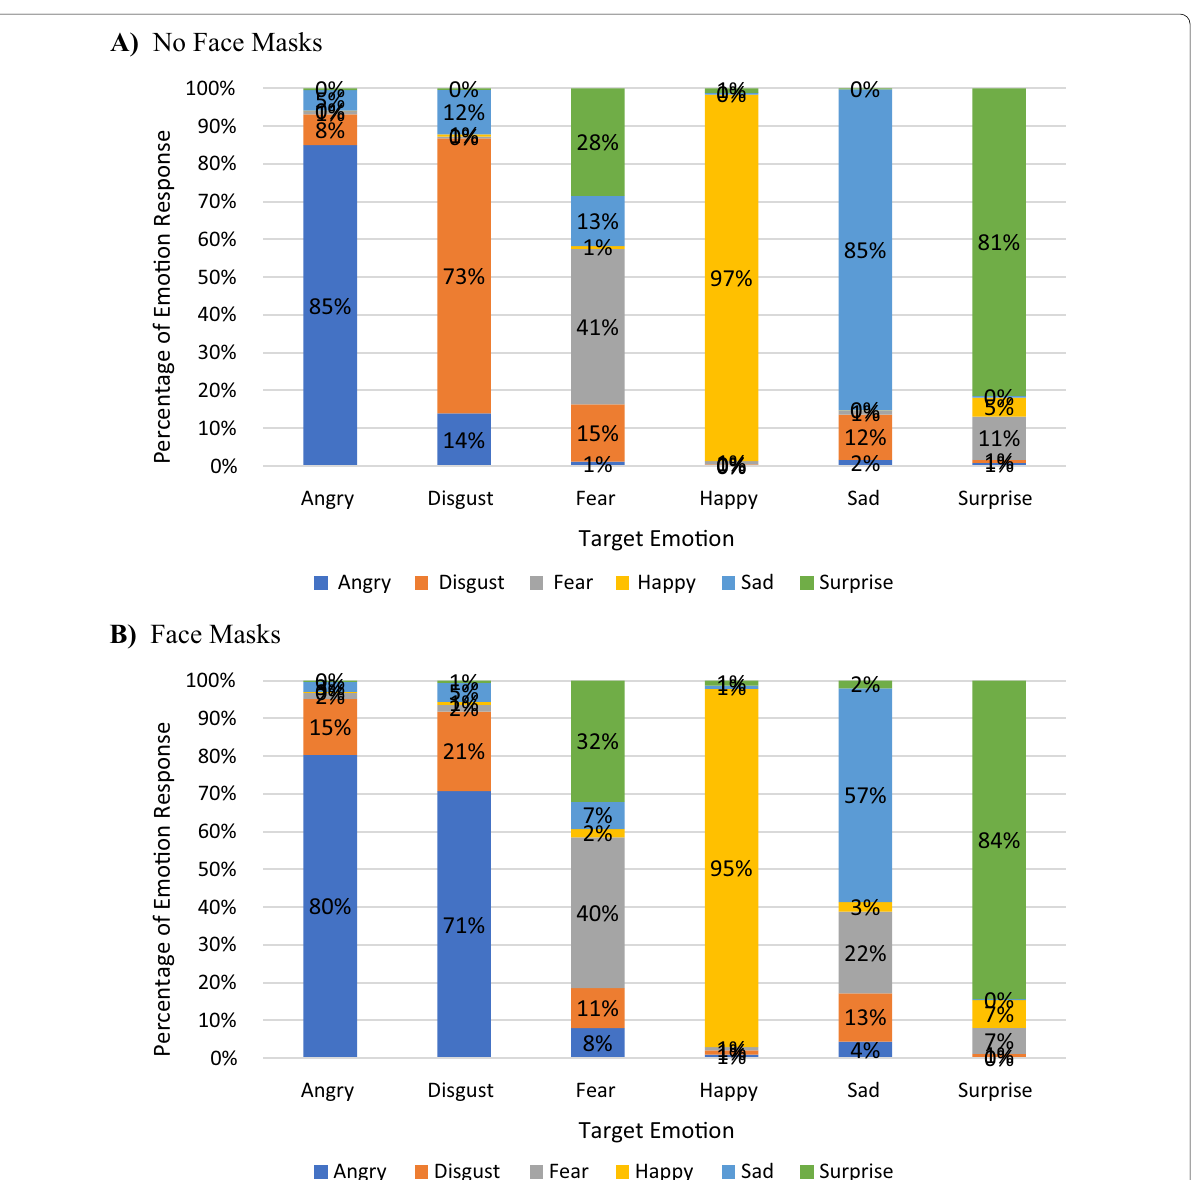
Fig. 3 Percentage of each emotion selected for each emotion condition. Each bar graph represents the mean percentage of correct and incorrect responses for no face mask ( A ) and face mask ( B ) conditions. Figure A shows the total correct responses in angry faces is 85%, while only 8% misattributed angry faces as disgust for unmasked conditions. Participants correctly identified disgust faces 71% in unmasked conditions while misattributing disgust with anger 21% of the time. Figure B shows the total correct responses in angry faces are 80%, while only 15% misattributed angry faces as disgust for masked conditions. Participants, however, correctly identified disgust faces in masked conditions only 21% of the time while misattributing digust faces for angry faces 71% of the